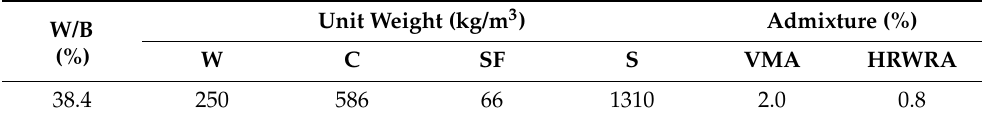
Table 1. Mixture